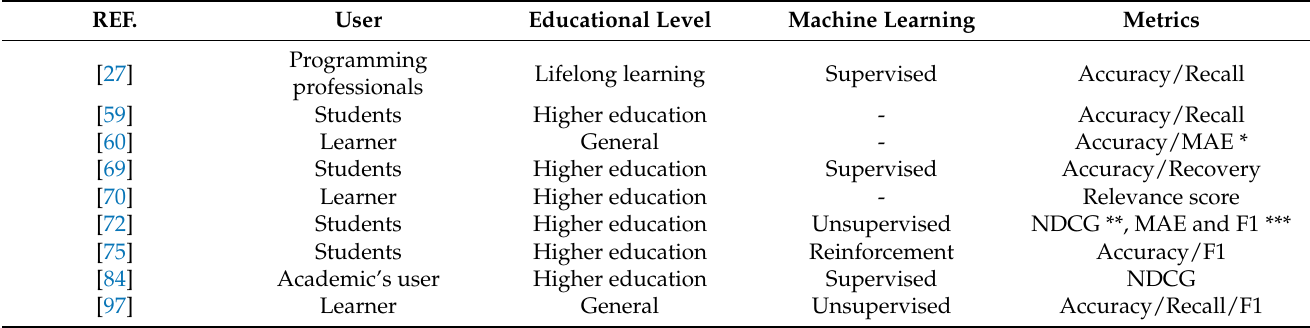
Table 10. Highlights of selected articles according to quality